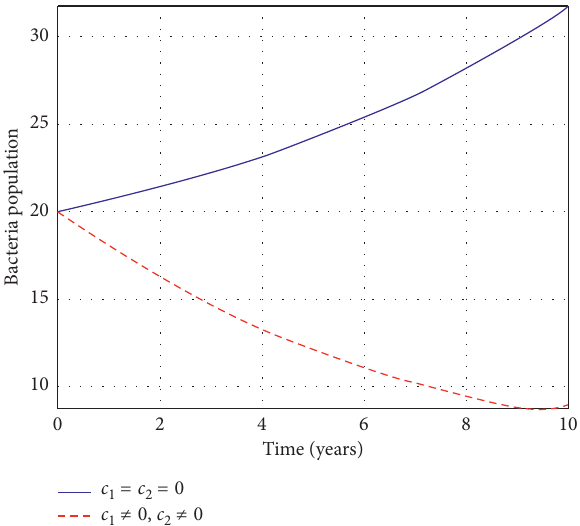
Figure 9: A graph showing the effectiveness of educational campaign as the only control measure to check its effect on the spread of